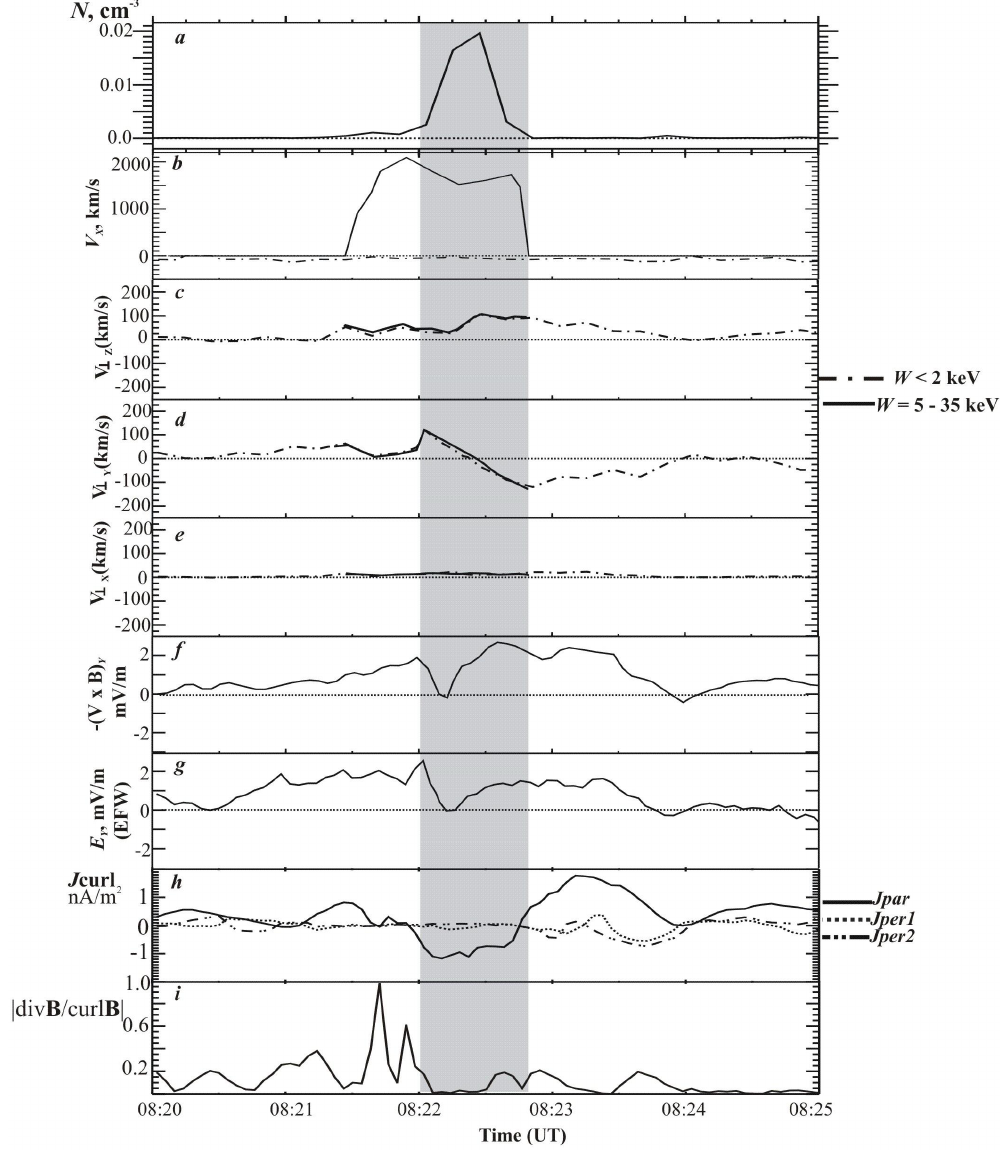
Fig. 3. From top to bottom: (a) Density, N , of high-energy ions ( W > 5keV); (b–e) the X-component of velocity and three components of perpendicular velocities of low-energy ions (30–2000eV, shown by dash-dot line) and high-energy ions ( > 5keV, displayed by solid line); (f) the Y GSE-component of the electric field calculated from the magnetic field and velocity of oxygen ions; (g) the dawn-dusk component of the electric field measured by the EFW instrument; (h) three components of the electric current calculated by the curlometer technique (parallel J par and perpendicular J per1, J per2 to the magnetic field); (i) values of | div B /curl B | . The interval of interest is shaded in